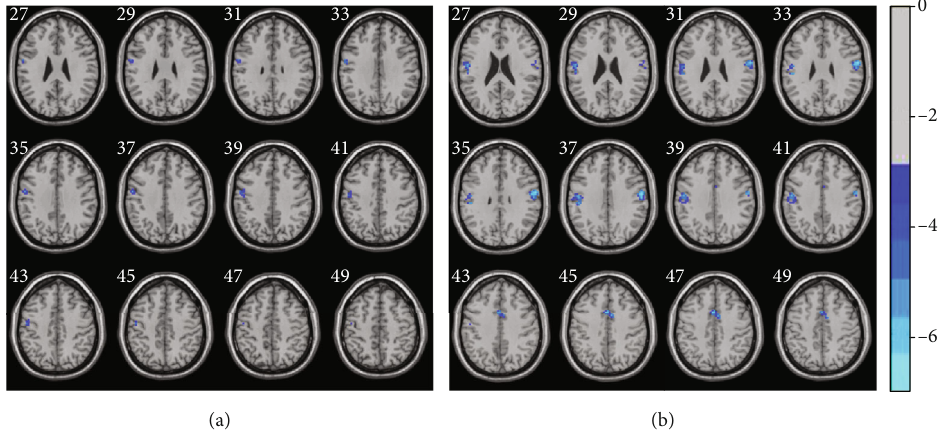
Figure 2: The outcome of ReHo di ff erences after acupuncturing at KI3 in the healthy youth group (a) and the healthy elder group (b) compared with their own resting-state fMRI. The ReHo maps were shown in the MNI space. The ReHo maps were calculated using the paired t test and GRF correction at a voxel level P < 0 : 001 and cluster level P < 0 : 05 (one-tailed). Edge connected cluster connectivity criterion, rmm = 5 . The cluster assignment has been shown in Table 2. The numbers in the fi gure indicated the z -axis in the MNI space. The color bar in the right panel indicated the intensity value of corresponding voxels. Table 2: Clusters of ReHo di ff erences between postacupuncture state and resting-state fMRI ∗ .